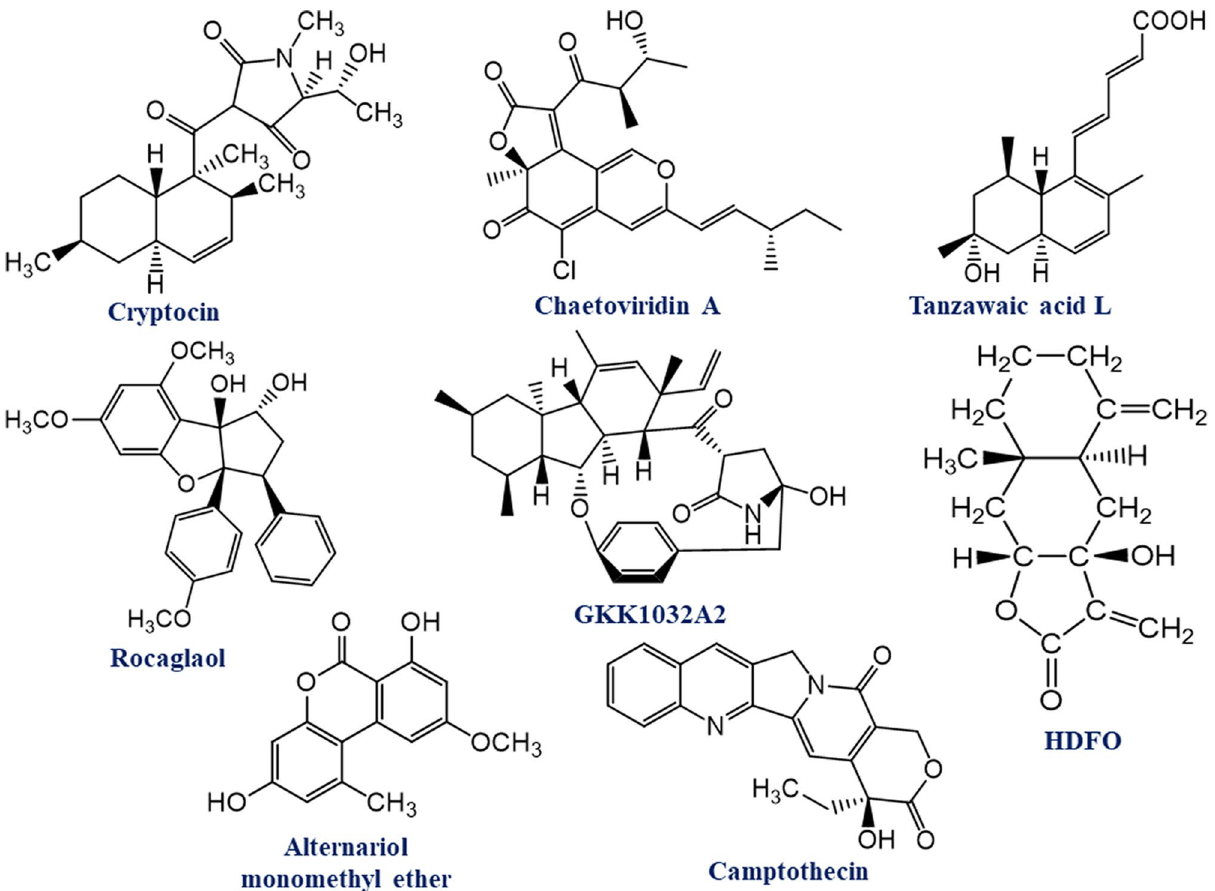
Figure 7. Two-dimentional (2D) chemical structure of the eight top ranked selected